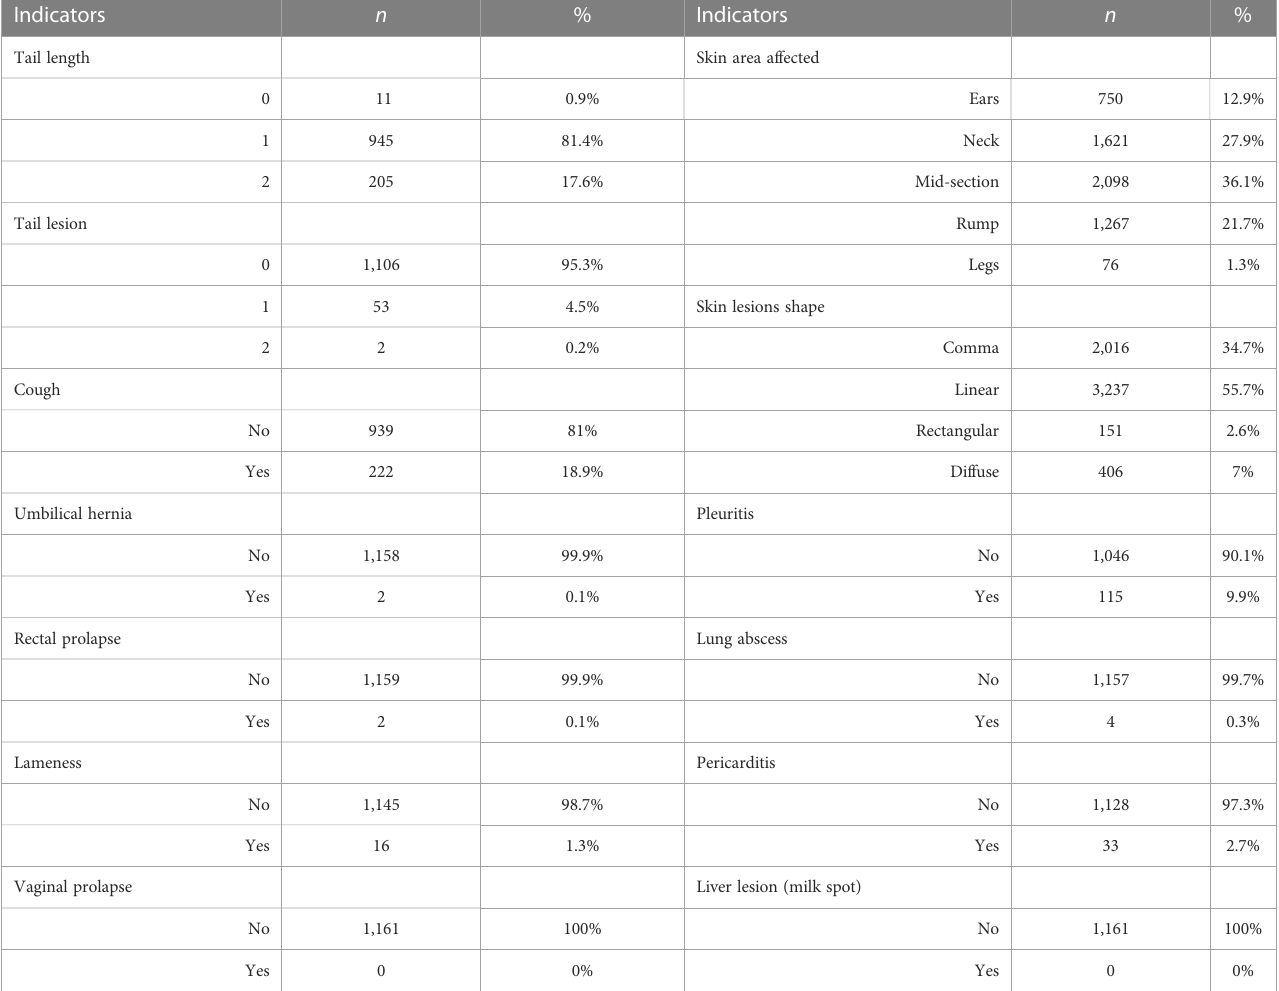
TABLE 3 Percentage of responses characterizing antemortem (i.e., tail length, tail lesion, cough, umbilical hernia, rectal prolapse, lameness, and vaginal prolapse), and postmortem (i.e., pleuritis, lung abscess, pericarditis, and liver lesions) indicators of fattening pig ’ s animal welfare, as estimated by descriptive statistics, in a Colombian slaughterhouse ( n = 1,161 pigs).